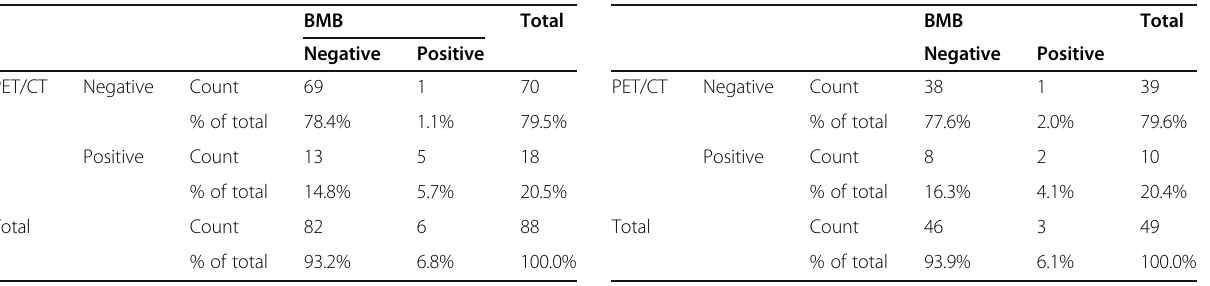
Table 10 Agreement between PET/CT and BMB in